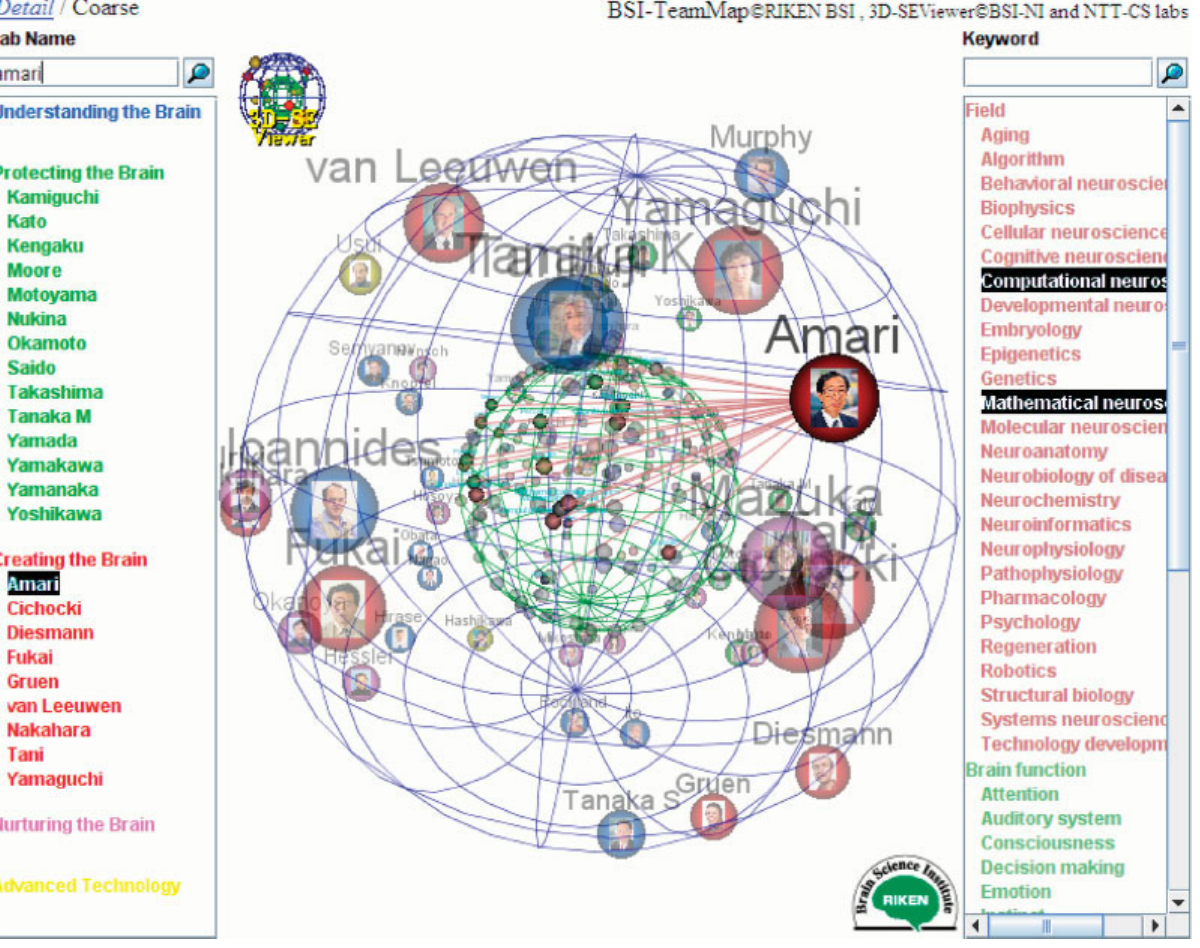
Figure 2. BSI-Team Map: 3D-SE viewer-based visualization of RIKEN BSI research teams . The nodes are colored according to the five team units listed in the left panel. It can be seen that nodes with the same color appear in the neighboring regions on the outer